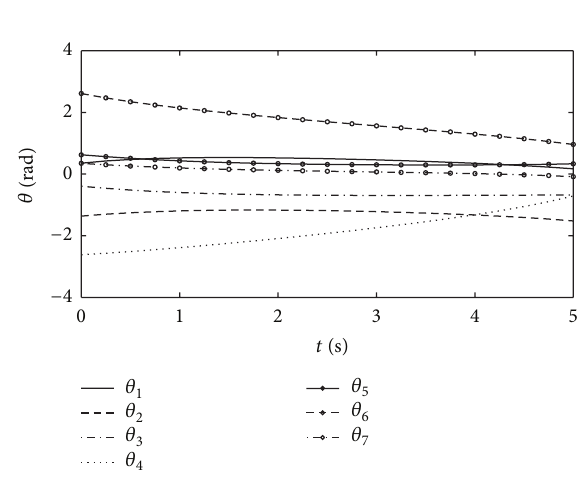
Figure 16: Angles of all joints.